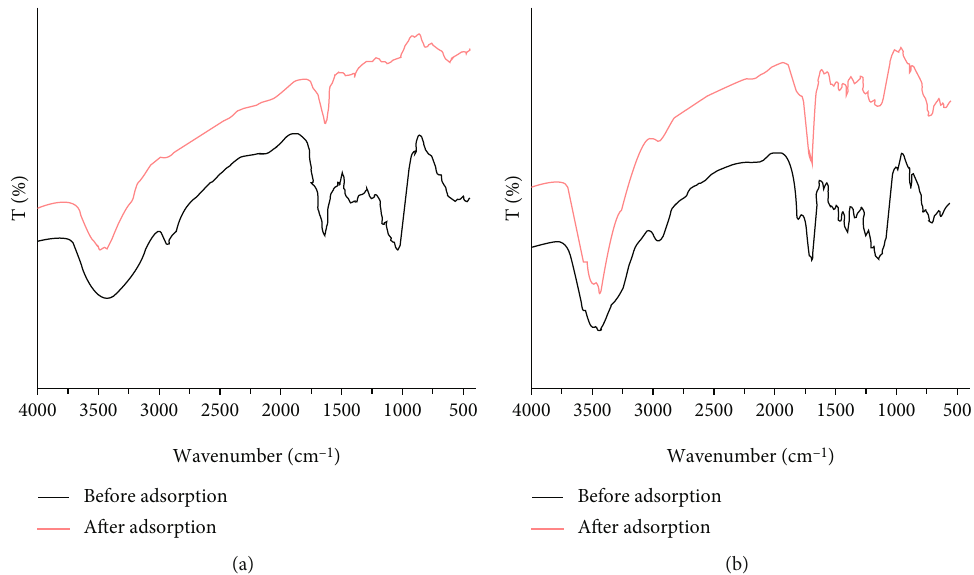
Figure 1: FTIR spectra of (a) BB and (b) EVML before and after adsorption.